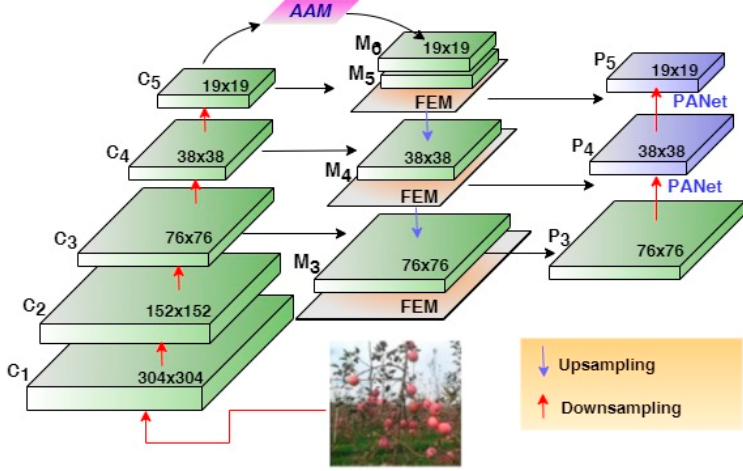
Figure 6. Combined attention with attribute augmentation model.